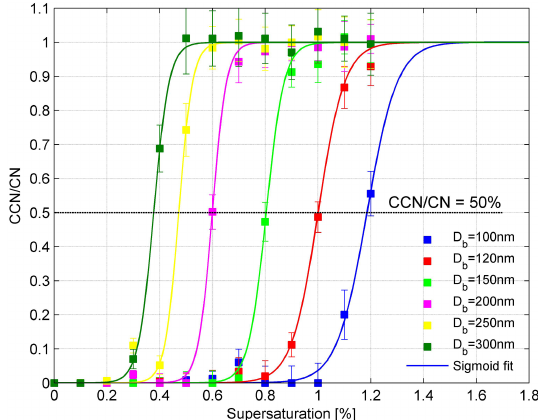
Figure 5. The average activation ratio versus supersaturation for different mobility diameters of silica particles. Error bars represent the standard deviation of the measured activation efficiency as a re- sult of about 20 measurements corresponding to each supersatura- tion of the